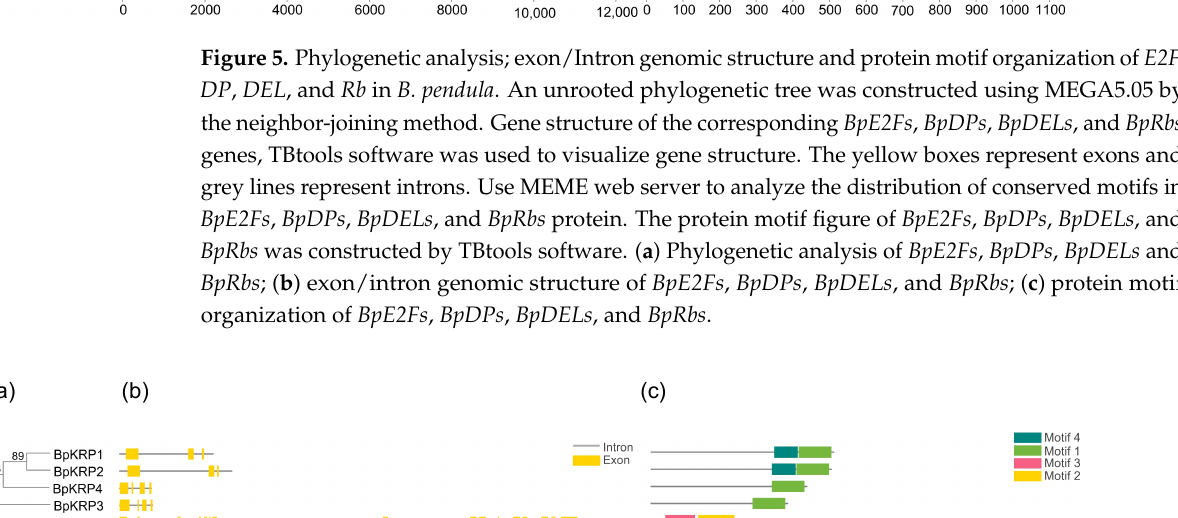
Figure 6. Phylogenetic analysis; exon/Intron genomic structure and protein motif organization of KRP and WEE in B. pendula . An unrooted phylogenetic tree was constructed using MEGA5.05 by the neighbor-joining method. Gene structure of the corresponding BpKRPs , BpWEEs genes, TBtools software was used to visualize gene structure. The yellow boxes represent exons and grey lines represent introns. Use MEME web server to analyze the distribution of conserved motifs in BpKRPs , BpWEEs protein. The protein motif figure of BpKRPs , BpWEEs was constructed by TBtools software. ( a ) Phylogenetic analysis of BpKRPs , BpWEEs ; ( b ) exon/intron genomic structure of BpKRPs , BpWEEs